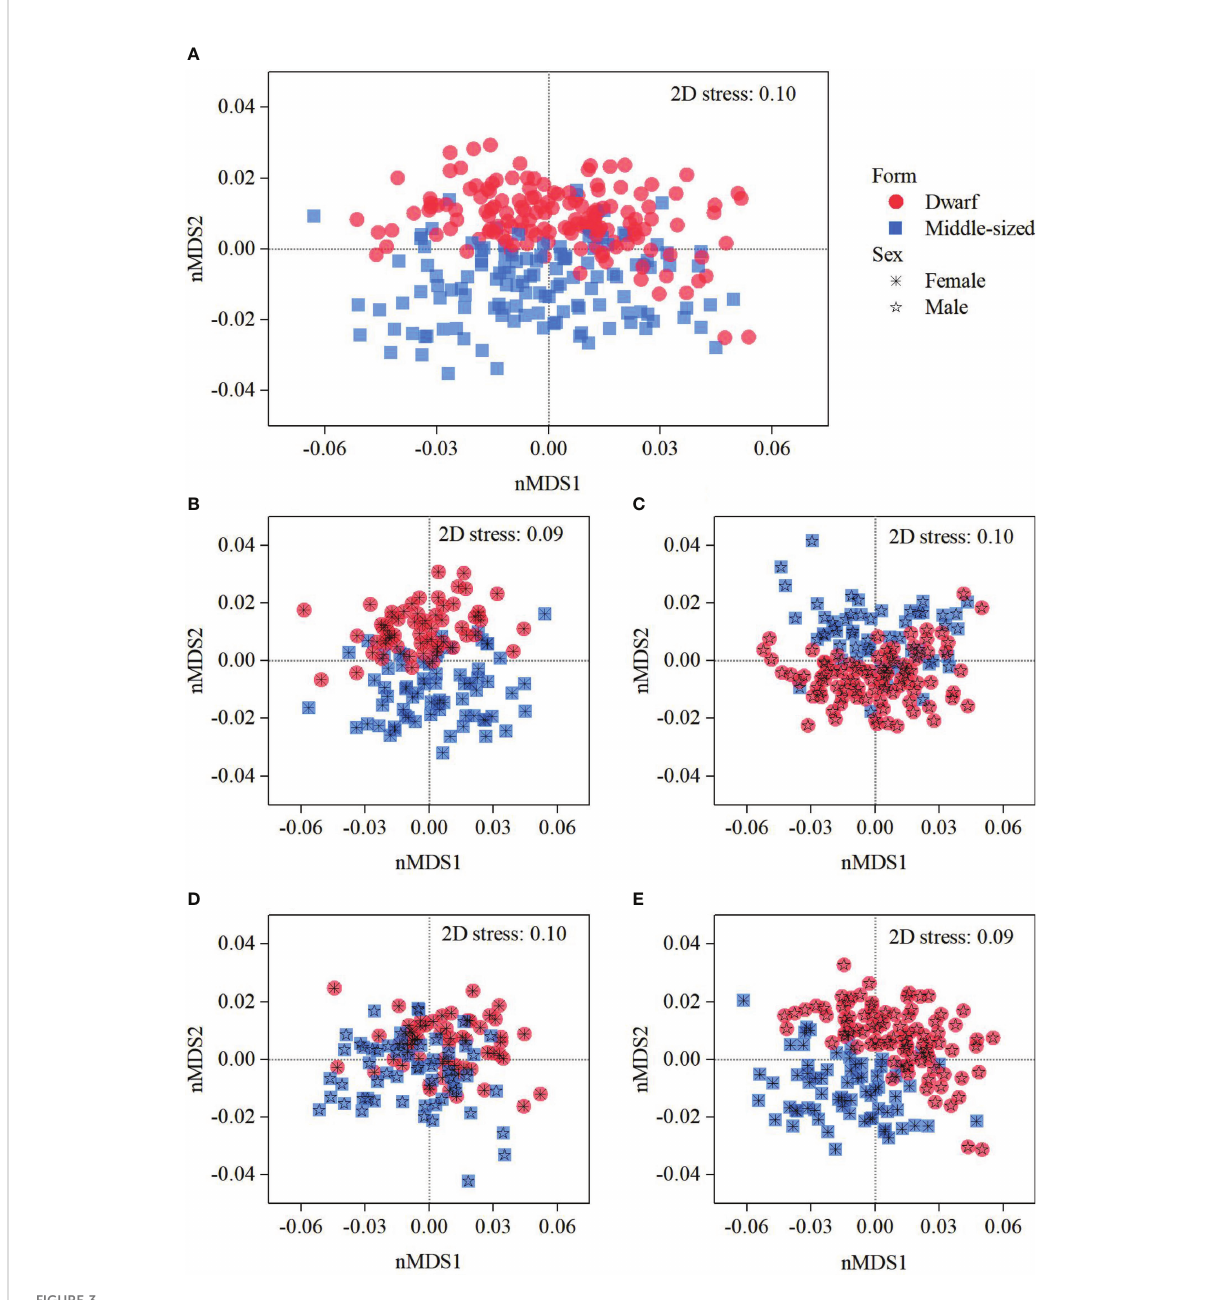
FIGURE 3 Non-metric multidimensional scaling (nMDS) ordination of gladius morphometric characteristics for dwarf without a dorsal photophore and middle-sized typical forms of Sthenoteuthis oualaniensis in the South China Sea. (A) , nMDS plots for the analysis between forms without regarding sexes; (B) nMDS plots for the analysis between females of both forms; (C) nMDS plots for the analysis between males of both forms; (D) nMDS plots for the analysis between female dwarf without a dorsal photophore and male middle-sized typical forms; (E) nMDS plots for the analysis between male dwarf and female middle-sized typical